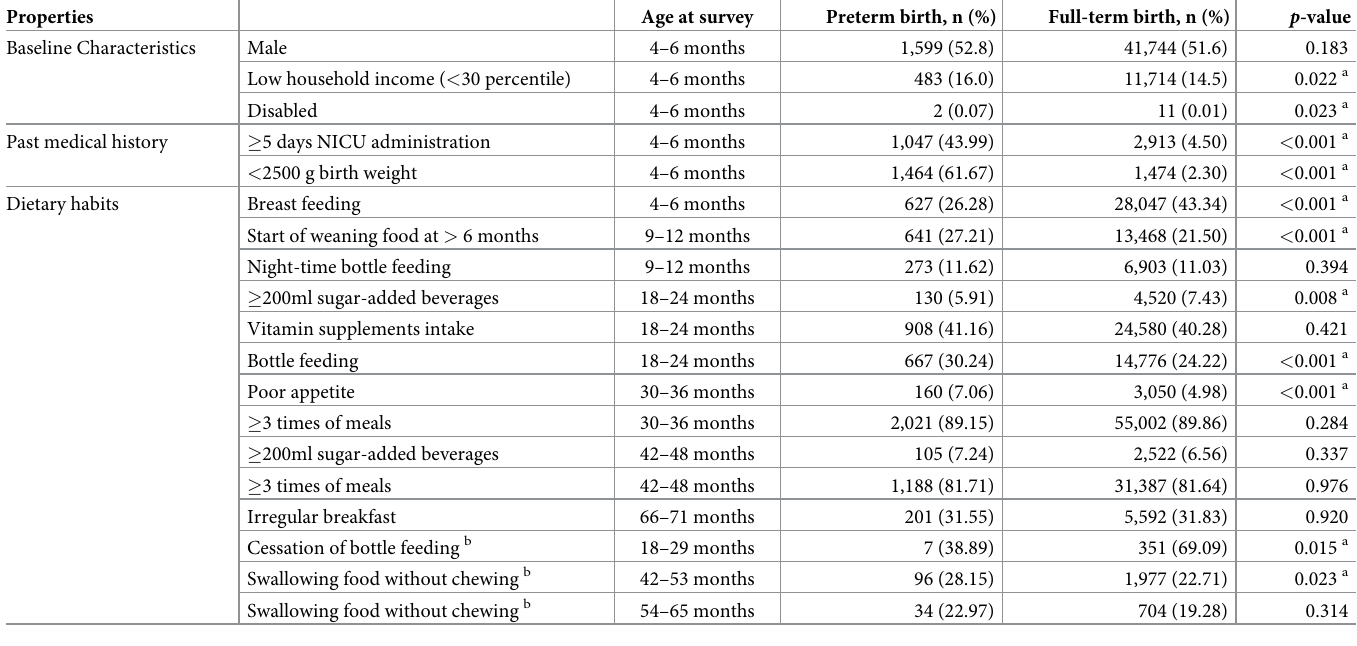
Table 2. Characteristics, medical history, and dietary habits of preterm and full-term children.